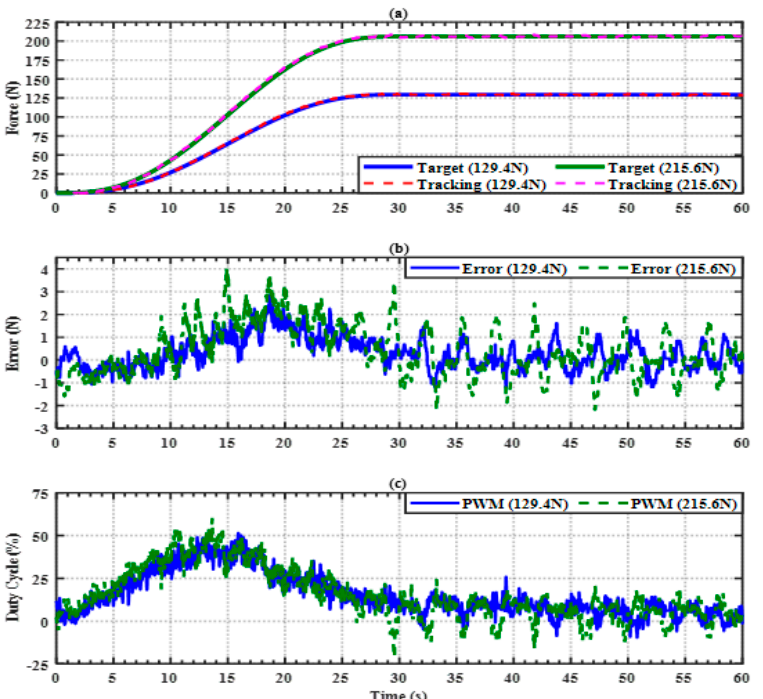
Figure 6. Static bodyweight unloading force control of ILESO − PSMC, 15% (129.4 N) and 25% (215.6 N) of female subject body weight (862.4 N). ( a ) Unloading force tracking response; ( b ) unloading force tracking error; ( c ) duty cycle of PWM.